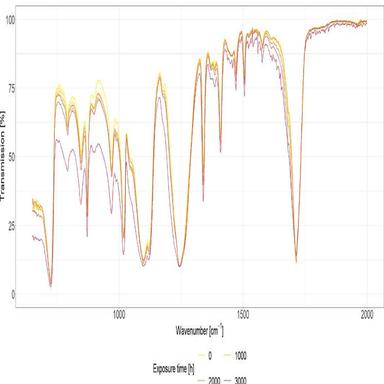
Example of part of an IR spectrum, measured for a module exposed to ageing Tropical 2 for 0, 1000, 2000 and 3000 h.